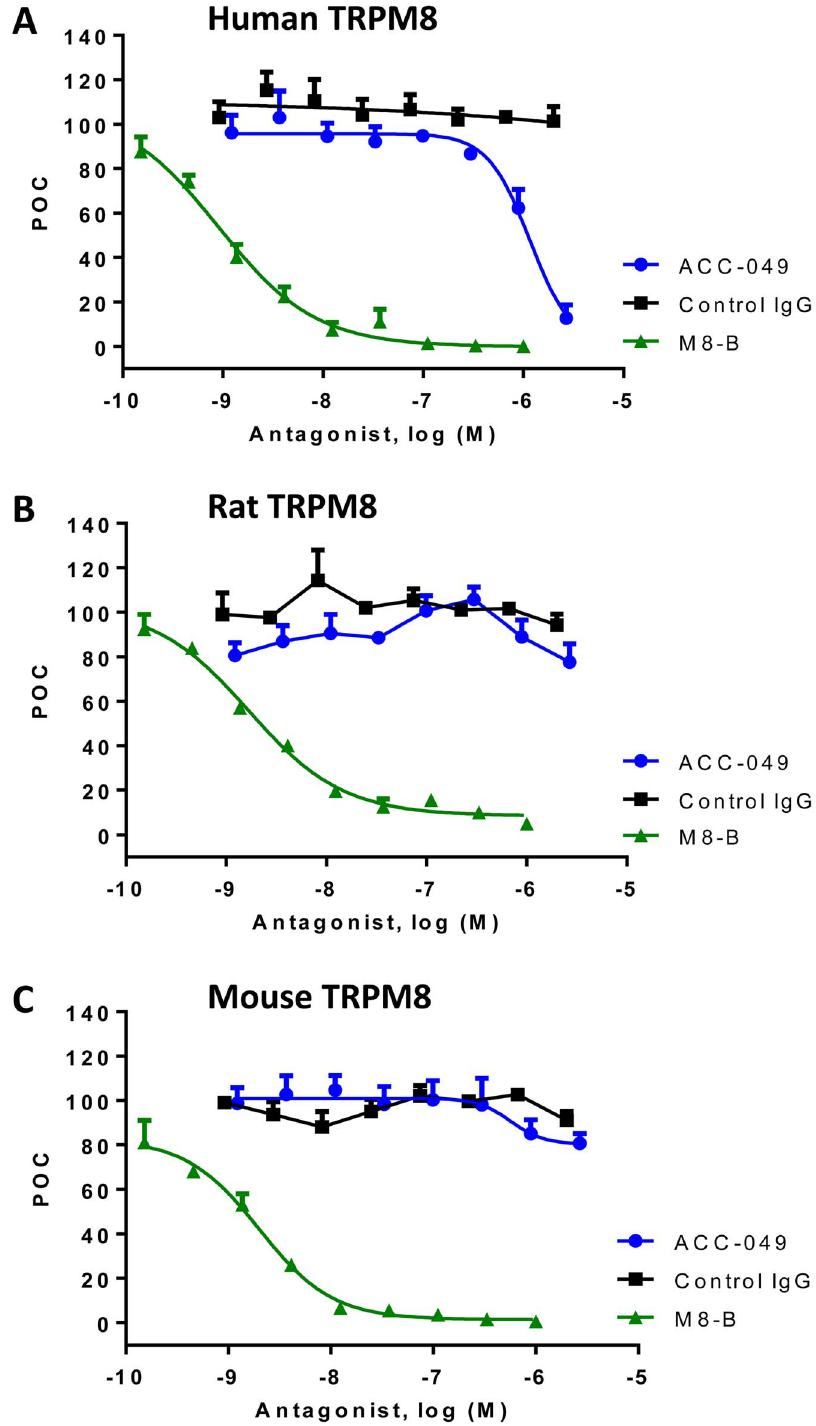
Figure 5. Menthol activation of TRPM8. Concentration dependent antagonism of menthol induced activation of the human (A), rat (B) or mouse (C) TRPM8 channels by ACC-049, control IgG and M8-B measured by 45 calcium uptake. Human TRPM8 channel activation was blocked by ACC-049 in a concentration dependent manner (A), but there was no antagonistic effect of ACC-049 on either rat (B) or mouse (C) TRPM8 channels activated by menthol. The small molecule antagonist positive control M8-B exhibited comparable responses on TRPM8 channels of all species tested (A–C). Values are means of triplicate measures and expressed as percent of control (POC). Menthol induced 45 Ca 2 + uptake was considered as 100 percent and wells with only assay buffer plus 45 Ca 2 + were set as zero percent.